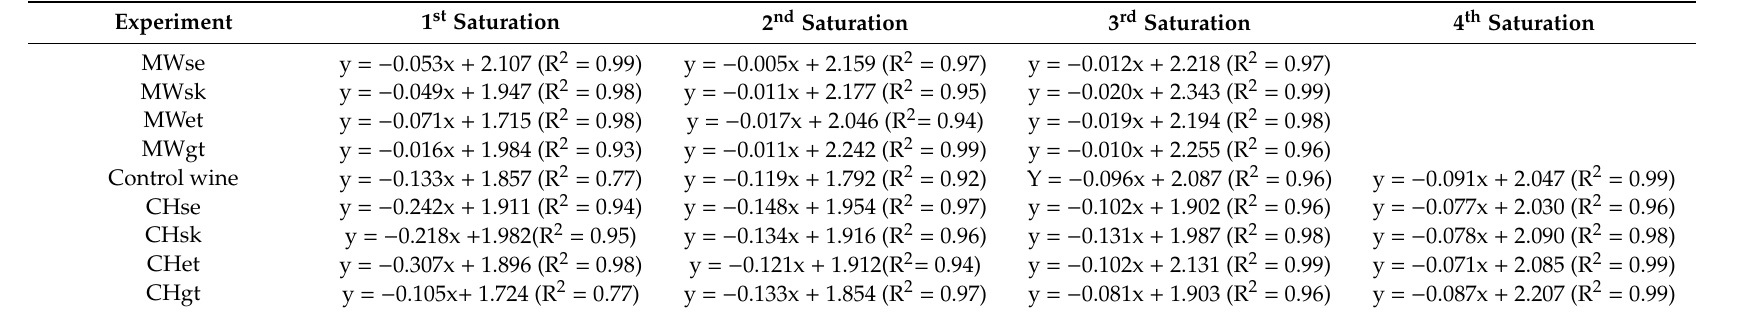
Table 2. First-order kinetic equations for the consumption of oxygen on model solutions and